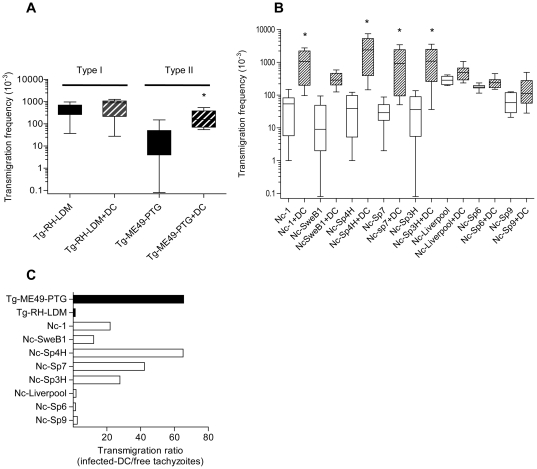
Transmigration of tachyzoites and tachyzoite-infected DC across cell monolayers.
A and B. Transmigration frequencies of free-tachyzoites or tachyzoite-infected-DC across polarized BeWo monolayers on transwell filters. (A) T. gondii (Tg-RH-LDM and Tg-ME49-PTG strains) and (B) N. caninum (Nc-1, Nc-Liverpool, Nc-SweB1, Nc-Spain 3H, Nc-Spain 4H, Nc-Spain 6, Nc-Spain 7 and Nc-Spain 9 isolates). Quantification was performed by counting plaques formed in the lower chamber HFF monolayer. Box-plot and whiskers graph represents the lower, upper quartiles, median and minimum–maximum of number of migrated parasites values (×10−3) of the replicates from at least three independent experiments. The black bars indicate T. gondii and the white bars indicate N. caninum. Asterisks indicate, for each isolate, statistically significant differences between the transmigration frequencies of infected-DC and free-tachyzoites (P<0.05; U-Mann Whitney). C. Ratio of the median transmigration frequencies across polarized BeWo monolayers of tachyzoite-infected-DC/free-tachyzoites. Extracellular tachyzoites of Tg-RH-LDM and Nc-Liverpool, Nc-Spain 6 and Nc-Spain 9 exhibited a potent transmigratory capacity and thus a relatively lower dependency on DC-mediated transmigration. In contrast, Tg-ME49-PTG and Nc-Spain 4H, Nc-Spain 7, Nc-Spain 3H, Nc-1 and SweB1 showed a preferential dependency on DC-mediated transmigration with variability among isolates. The black bars indicate T. gondii and the white bars indicate N. caninum.